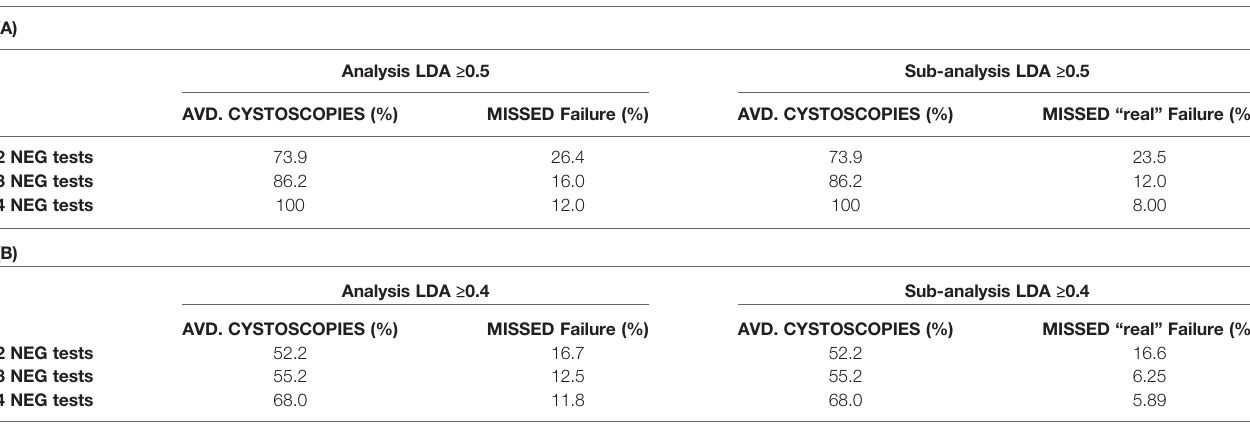
TABLE 3A – B | The data are displayed with two different LDA cut